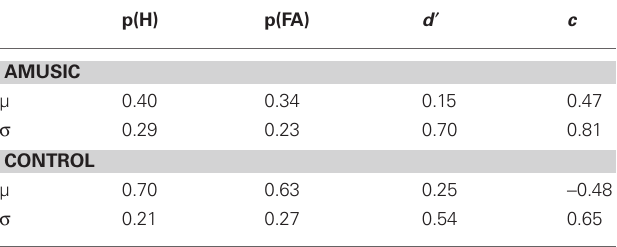
Table 5 | mean hit rates, false alarm rates, and d ′ and c values for amusic and control